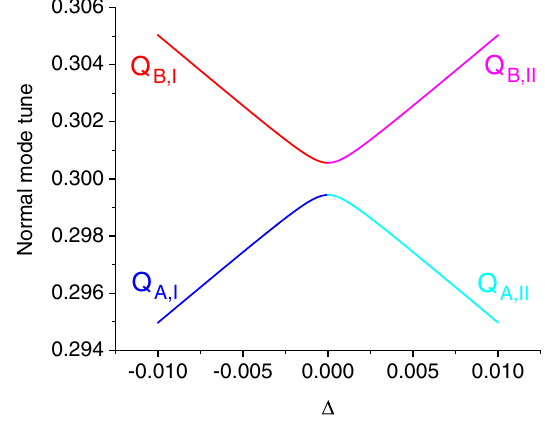
FIG. 3. Normal mode tunes of the original ring one-turn map around the resonance. The parameters are the same as those in Fig. 2. In this plot, solution I is used for Δ < 0 and solution II for Δ > 0